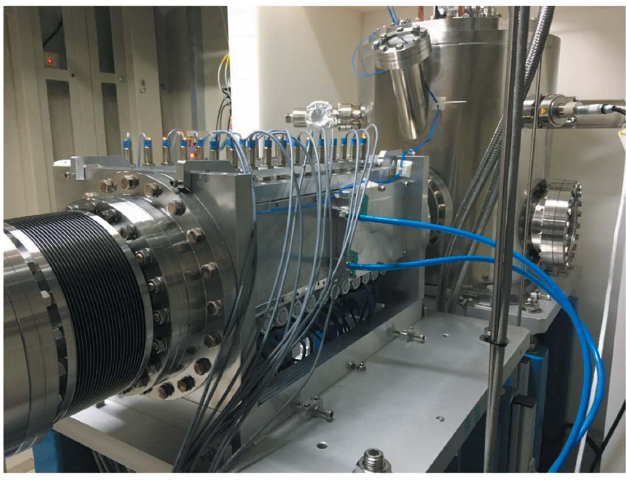
Figure 17 Attenuator system installed in the TPS 31A beamline.